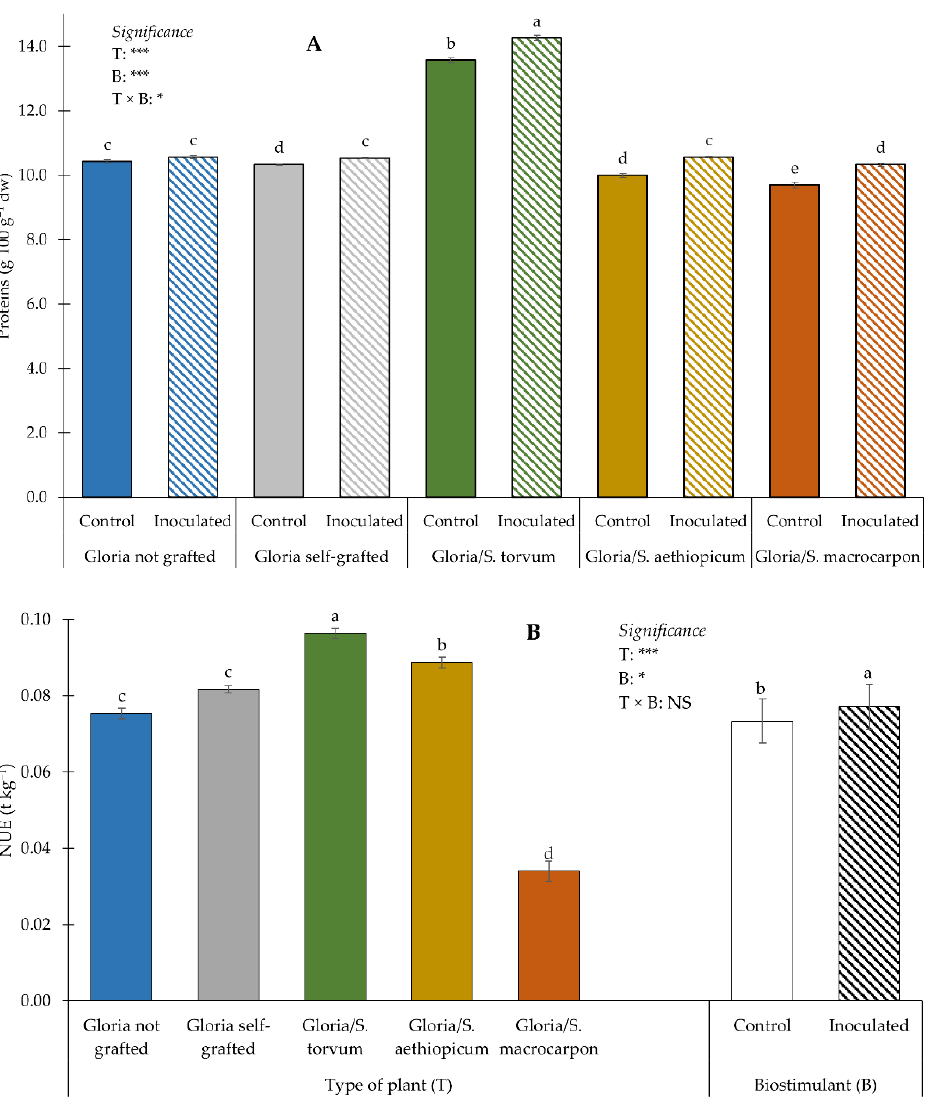
Figure 2. Influences of the type of plant and biostimulant application on the fruit protein content ( A ) and nitrogen use efficiency (NUE) ( B ) of eggplant. Mean values with different letters are signifi- cantly dissimilar at p ≤ 0.05, according to Tukey’s test. NS = not significant; * = significant at p ≤ 0.05; *** = significant at p ≤ 0.001. Bars i ndicate the means ± standard error.